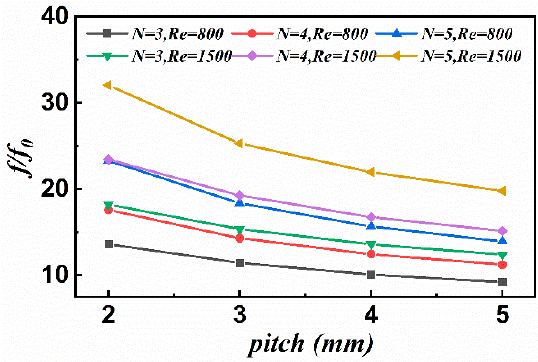
Figure 13. Variations of f/f o with deflector pitch at A = 30 ◦ .